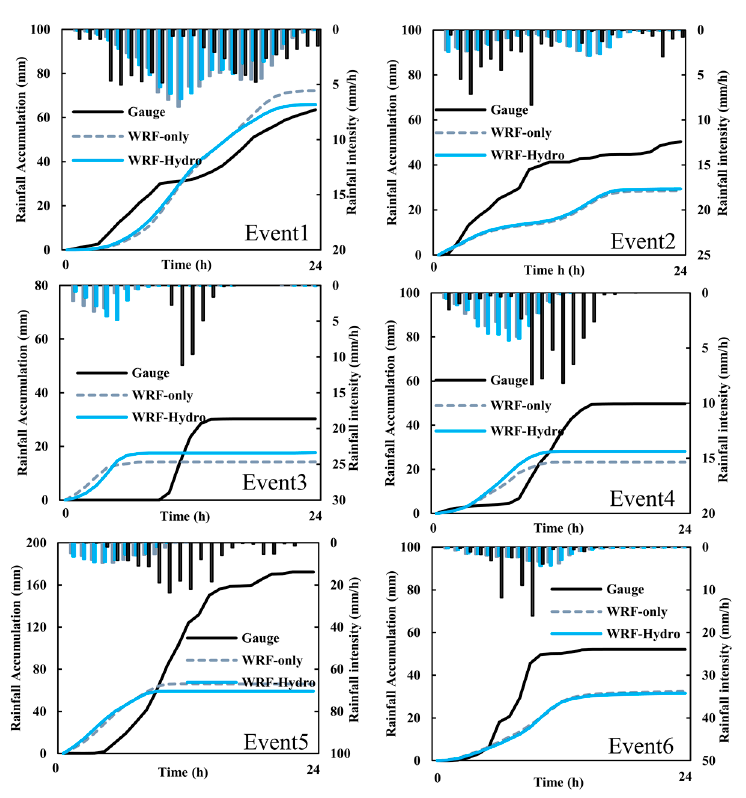
Figure 2. The observed and simulated 24 h rainfall accumulations for the six storm events. Table 6. RE values of the 24 h rainfall accumulations simulation: ( a ) Weather Research and Forecasting model (WRF-only); ( b ) the fully coupled WRF /